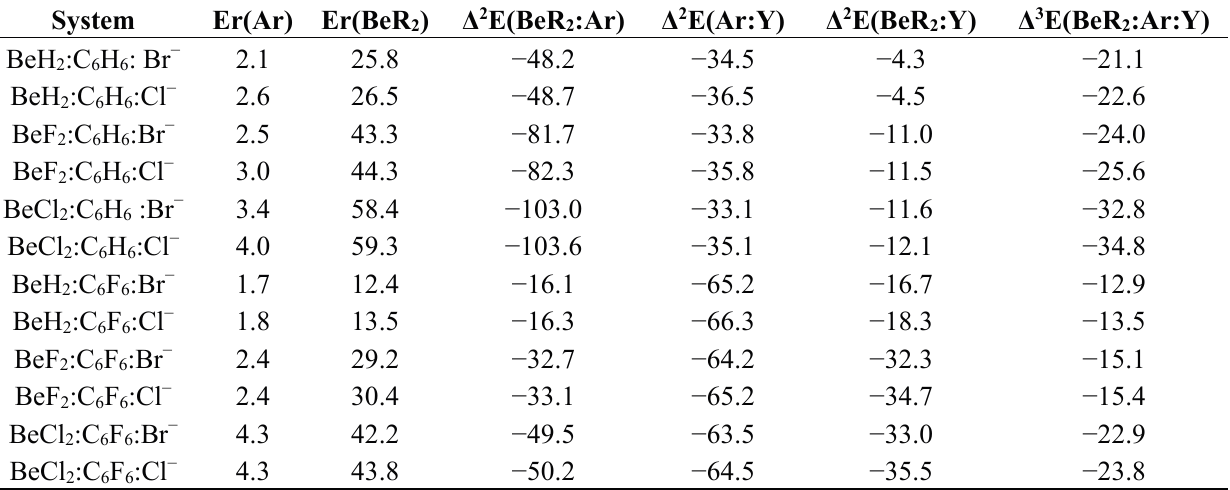
Table 7. Many body Interaction energy (MBIE) partition term (kJ/mol) in the ternary systems